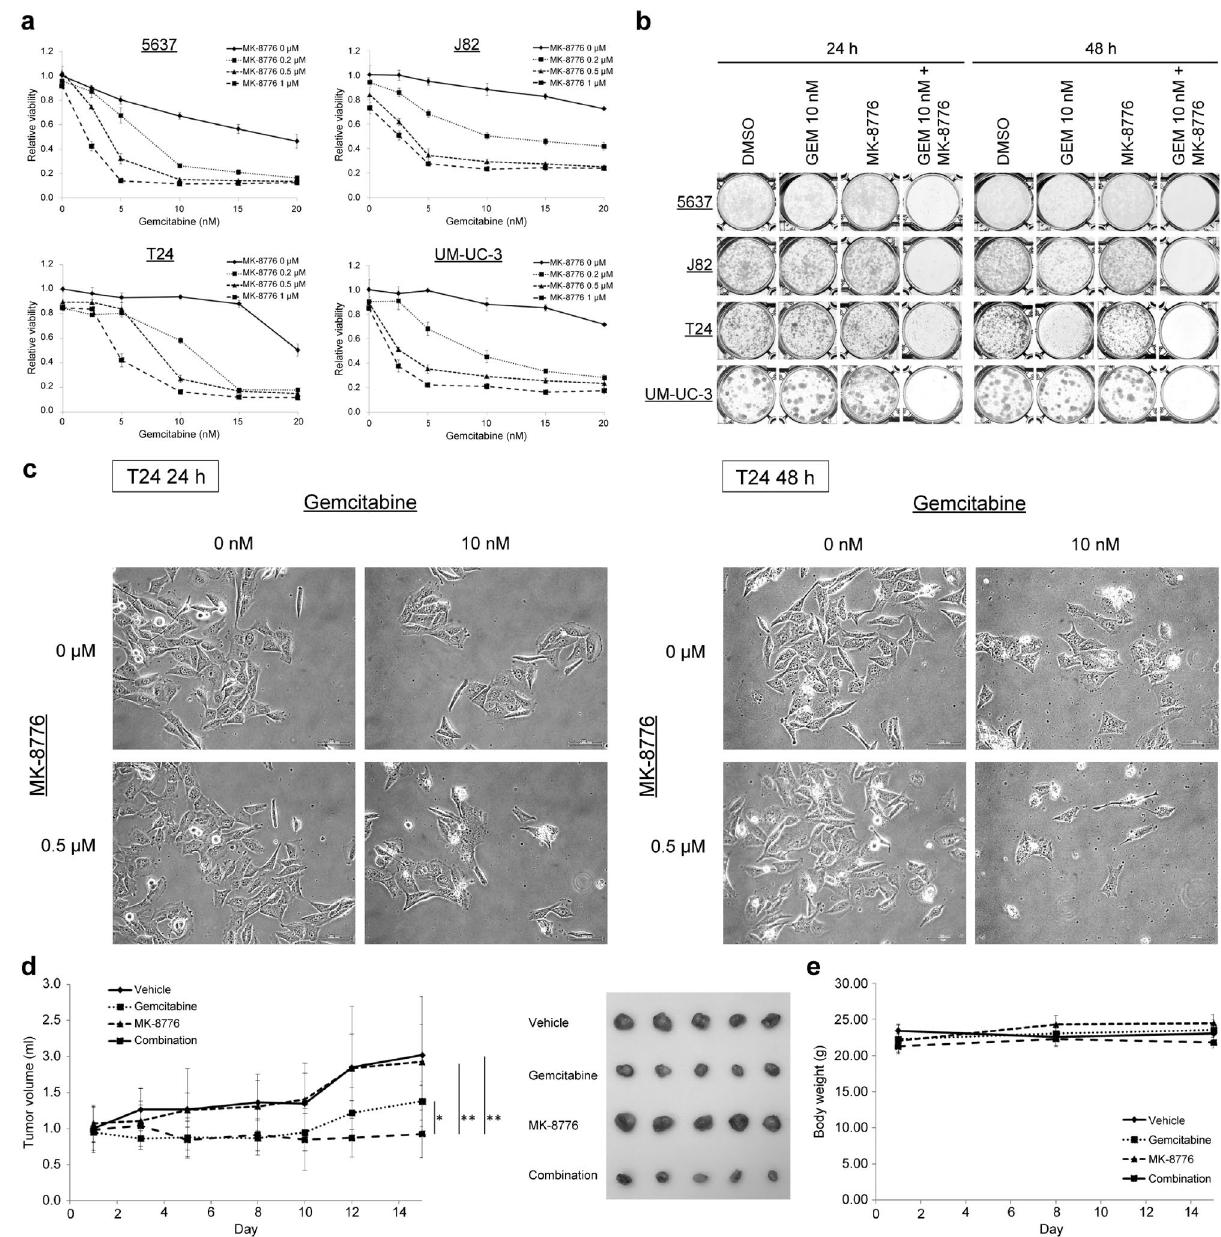
Figure 1. Viability and clonogenicity of bladder cancer cells after single and combined treatment. ( a ) Cell viability in 5637, J82, T24, and UM-UM-3 cells was determined by MTS assays (mean ± SD, n = 4) after 48 h. ( b ) Clonogenicity assays in bladder cancer cells treated with gemcitabine, MK-8776 (0.5 μM), or both compounds for 24 or 48 h. GEM, gemcitabine. ( c ) Morphology of T24 cells after treatment with gemcitabine and MK-8776. Scale bar = 100 μm. ( d ) In vivo efficacy of the combination treatment. UM-UC-3 cells were used for the subcutaneous tumor models. The vehicle group received DMSO and the other three groups received either gemcitabine (20 mg/kg), MK-8776 (4 mg/kg), or both (mean ± SD, n = 5, * p = 0.0593, ** p = 0.0119). ( e ) Changes in body weight (mean ± SD, n = 5). No significant change in body weight was observed among the four groups at day